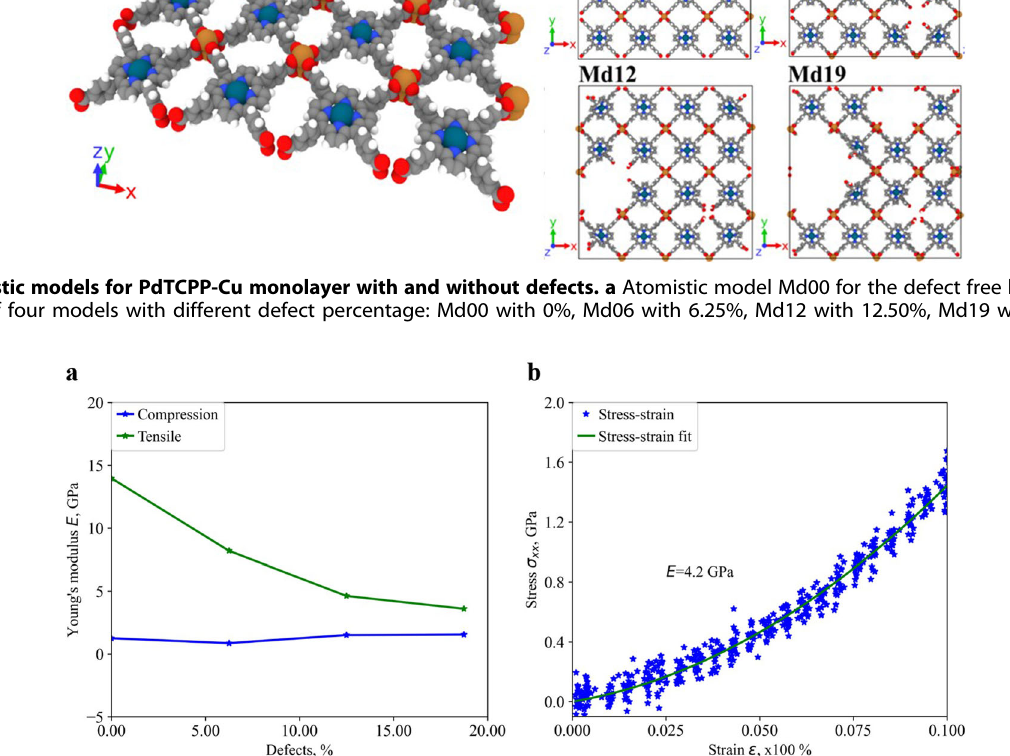
Fig. 5 In fl uence of defects and water on Young ’ s modulus in MD simulations. a Calculated Young ’ s moduli at various percentages of vacancy defects at 1 K and in vacuum using models Md00 till Md19. b Stress-strain curve of defect free PdTCPP-Cu (model Md00) on top of a water layer obtained at T = 300 K with maximum 10% uniaxial tensile strain. The data were fi tted with Eq. (13) to extract the Young ’ s